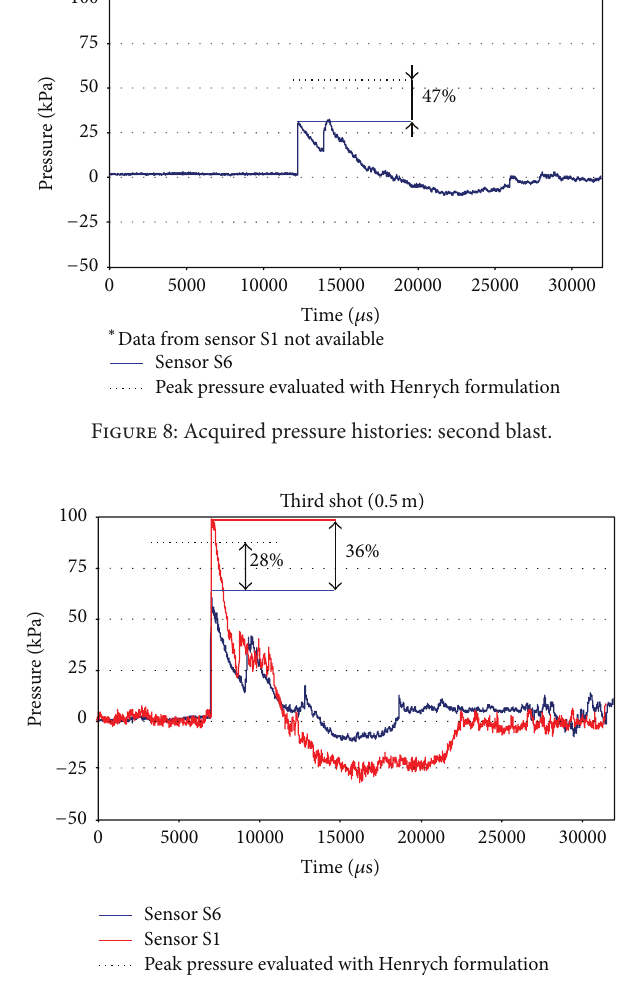
Figure 9: Acquired pressure histories: third